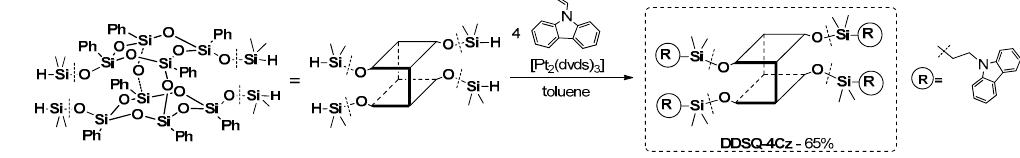
Figure 23. Reaction path towards tetra(carbazole)-substituted DDSQ (DDSQ-4Cz).